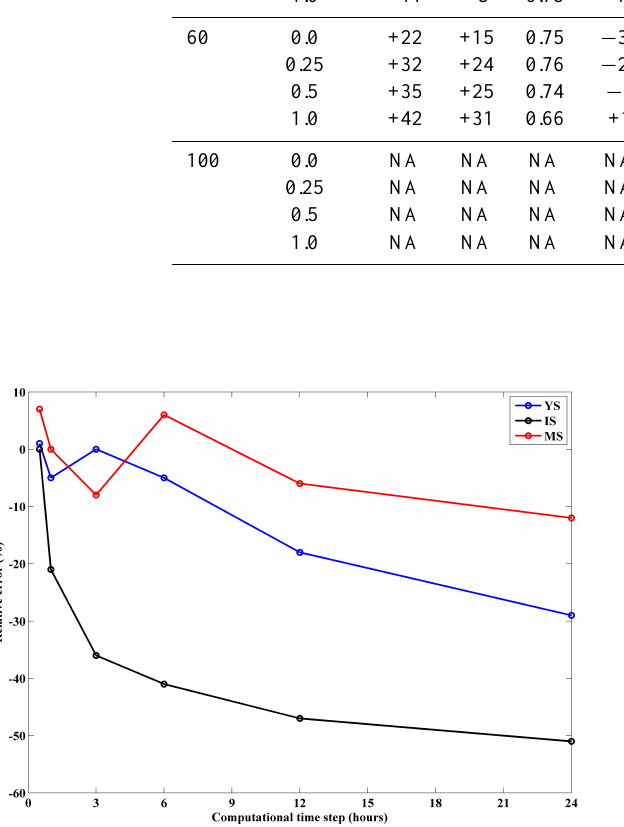
Fig. 3. Sensitivity of the data-driven soil water balance model to the computational time step ( 1t ). The relative error shown is the lowest error obtained by the combination of Z r and I max for each time step.